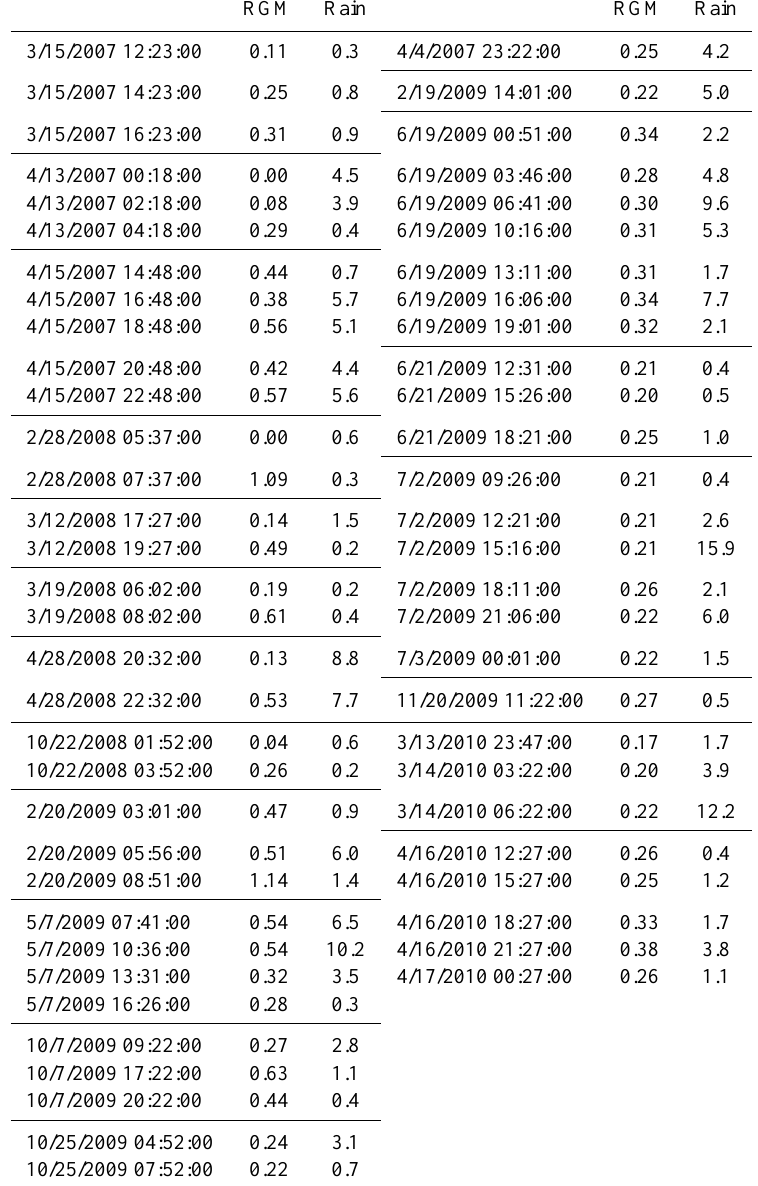
Table 2. At TF (coastal) Rainfalls during which RGM levels (ppqv) were not washed out maintaining above the LOD together with pre- cipitation amount (mm) for each sample cycle. The rainfall episodes on the left saw increasing RGM levels, and the ones on the right had sustained RGM levels during rainfalls that lasted hours. RGM Rain